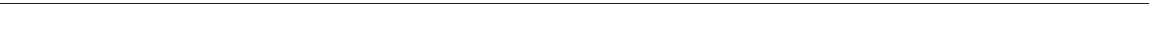
Fig. 2 DOT1L selectively attenuates low-avidity T-cell responses. a , b CD3 + T cells treated with SGC0946 or DMSO were labeled with CFSE and restimulated with aAPC/mOKT3 (day 0). The mean fl uorescence intensity of CFSE on day 4 ( a ) and representative CD69 expression on day 1 ( b ) are shown ( n = 4 cultures, unpaired two-sided t -test for each T-cell population). c IFN- γ production by SGC0946- or DMSO-treated T cells upon restimulation with aAPC/mOKT3 was analyzed with fl ow cytometry ( n = 5 different donor samples, paired two-sided t -test). d CD8 + T cells retrovirally transduced with HLA-A2/MART1 TCR (clone DMF5) were treated with SGC0946 or DMSO and analyzed for intracellular IFN- γ in the CD8 + A2/MART1 27 – 35 multimer + T- cell population upon stimulation with aAPC/A2 loaded with 10 μ g/ml heteroclitic A2/MART1 27 – 35 peptide ( n = 5 different donor samples, paired two- sided t -test). e – h CD8 + T cells individually transduced with the indicated TCR α / β genes were treated with SGC0946 or DMSO for 1 week and stimulated with aAPC/A2 loaded with 10 μ g/ml A2/MART1 peptide. The IFN- γ secretion was analyzed with ELISPOT assays ( e , n = 3 cultures; unpaired two-sided t - test). The left y -axis is for TCR clone 413, and the right is for the other TCR clones. CD69 expression on day 1 ( f , n = 5 different donor samples, paired two- sided t -test) and CFSE dilution on day 4 ( g , n = 4 different donor samples, paired two-sided t -test) were analyzed within the TCR-transduced CD8 + T-cell population. The secretion of IFN- γ relative to the maximal response was analyzed by ELISPOT assays ( h , n = 3 cultures for each). i A2/MART1 high-avidity T cells (clone 830) were treated with SGC0946 or DMSO and stimulated with aAPC/A2 pulsed with the indicated peptides (10 ng/ml). IFN- γ secretion was analyzed with ELISPOT assays ( n = 3 cultures, unpaired two-sided t -test). NS, not signi fi cant. Horizontal lines represent the means ±